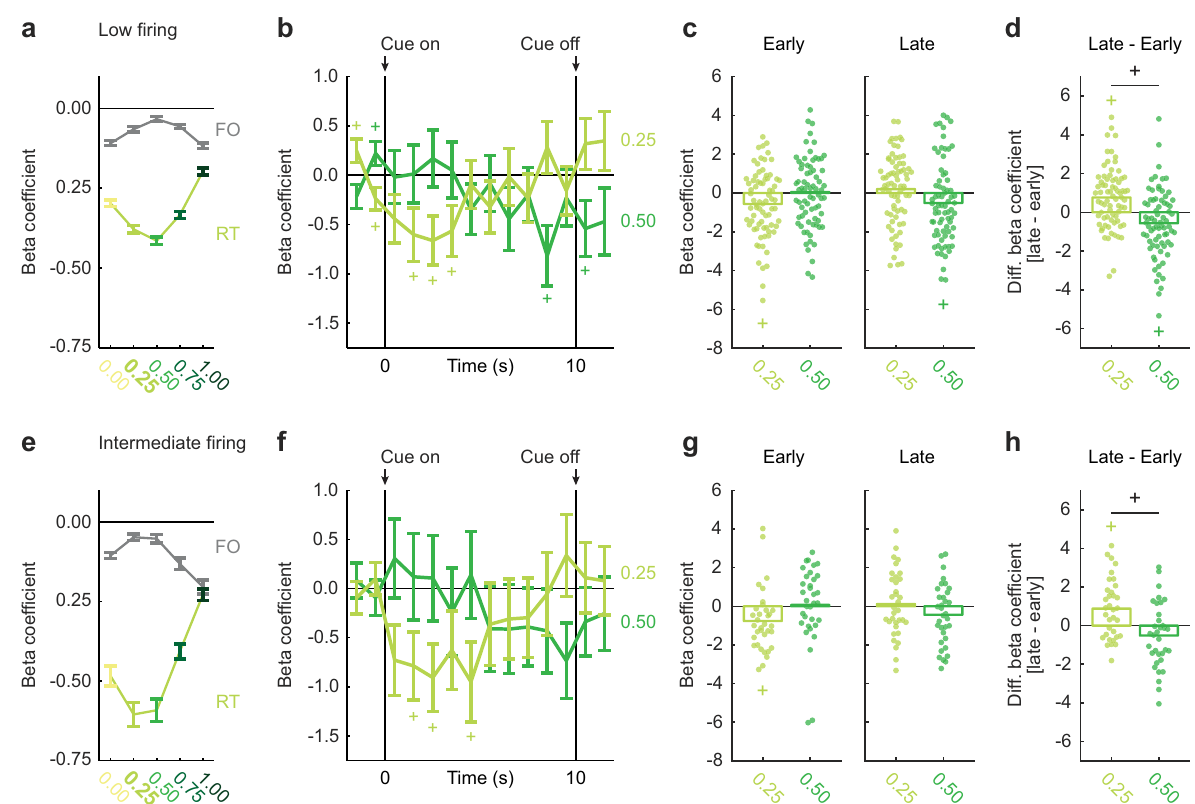
Fig. 4 Low fi ring and Intermediate fi ring neurons dynamically signal relative threat. a Mean ± SEM beta coef fi cients are shown for each regressor (RT, relative threat; FO, fear output), during the 10 s cue presentation, for each assignment from 0 to 1 in 0.25 increments (0.00, 0.25, 0.50, 0.75, and 1.00), for the Low fi ring neurons ( n = 74). b Mean± SEM beta coef fi cients are shown for two relative threat regressors (0.25, assignment, green yellow; 0.50, assignment, green), from 2 s prior to cue onset to 2 s following cue offset in 1 s intervals, for the Low fi ring neurons. Cue onset and offset are indicated by vertical black lines. c Mean (bar) and individual (data points), early ( fi rst 4 s of cue) and late (last 2 s cue plus 2 s delay) beta coef fi cients for two relative threat regressors (assignment, 0.25 and 0.50) are shown for Low fi ring neurons (colors maintained from b ). d Mean (bar) and individual (data points), differential beta coef fi cients ([late - early]) for two relative threat regressors (assignment, 0.25 and 0.50) are shown for Low fi ring neurons. e – h Identical graphs made for the Intermediate fi ring neurons ( n = 34), as in a – d . + 95% bootstrap con fi dence interval for differential beta coef fi cient does not